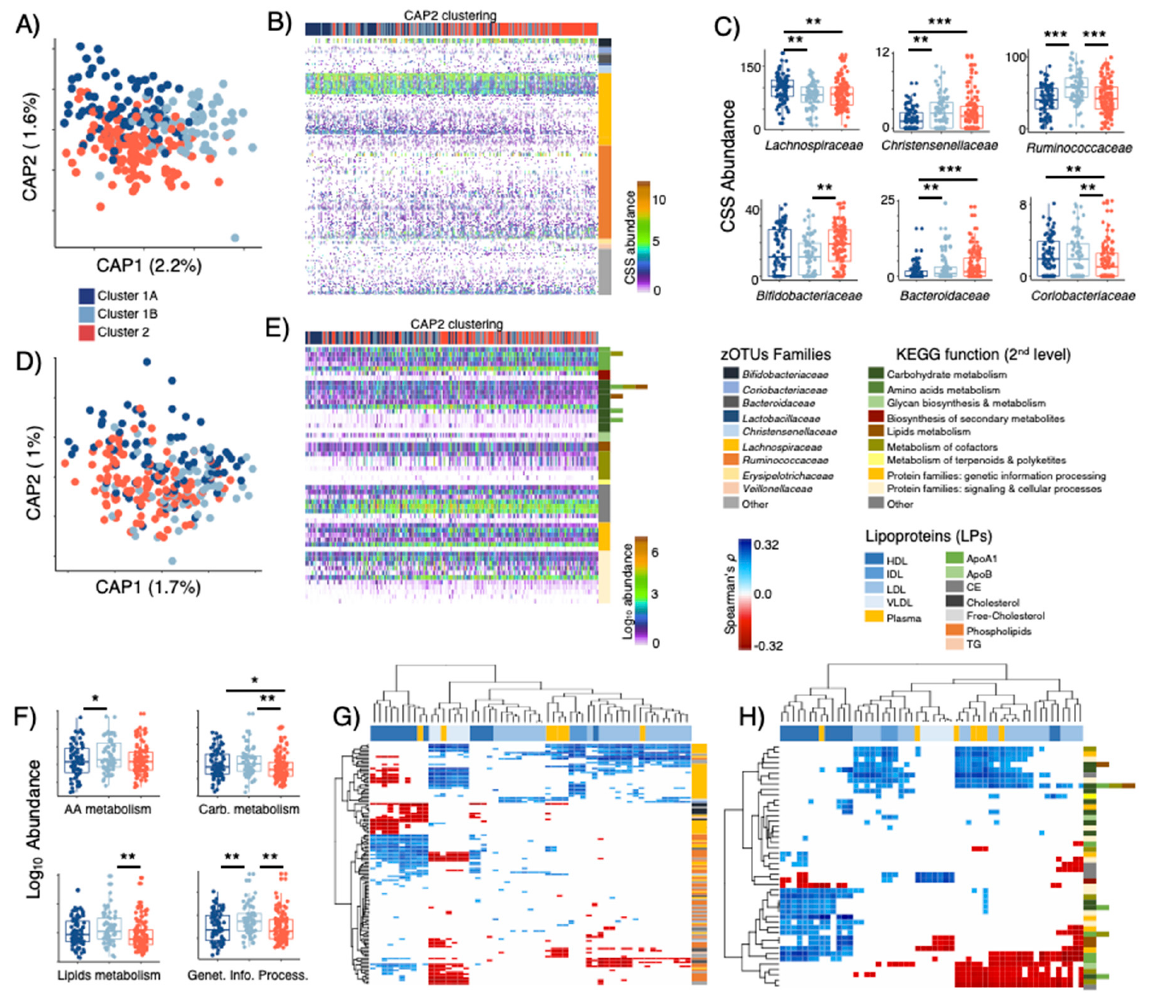
Figure 4. ( A ) Distance-based RDA (Canberra dissimilarity) displaying discrimination of LPD clusters based on selected zOTUs ( p = 0.001, explained variance = 3.8%) and ( D ) KOs-PICRUSt ( p = 0.001, explained variance = 2.7%) selected through Random Forests. ( B ) Overview of selected zOTUs and ( E ) KOs-PICRUSt clustered using Canberra distances and general agglomerative hierarchical clustering procedure based on ward2. ( C ) Distribution of zOTUs summarized to family level and ( F ) KOs-PICRUSt summarized to 2nd level KEGG function across subjects belonging C1A, C1B and C2 LPD groups. Heatmaps displaying significant (False Discovery Rate corrected, FDR ≤ 0.05) Spearman’s rank correlations between ( G ) zOTUs and LPD sub-fractions, as well as ( H ) KOs-PICRUSt and LPD sub-fractions. Stars show statistical level of significance (* p ≤ 0.05, ** p ≤ 0.01, *** p ≤